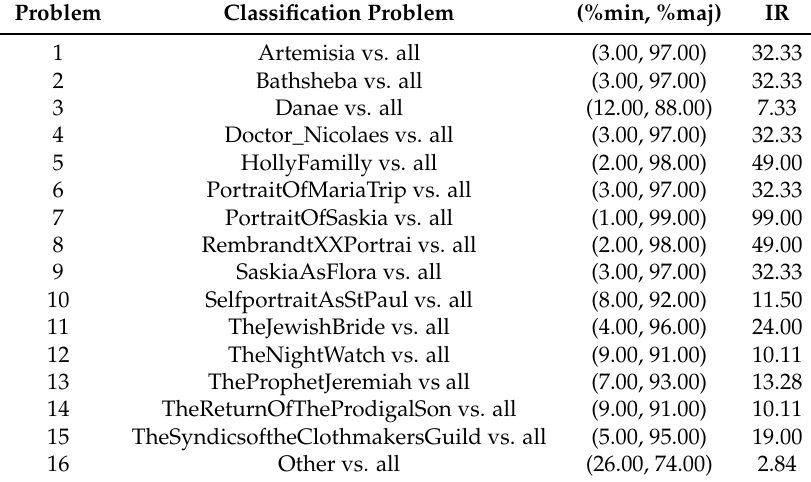
Table 14. One-versus-All (OvA) configuration for the dataset in [26].